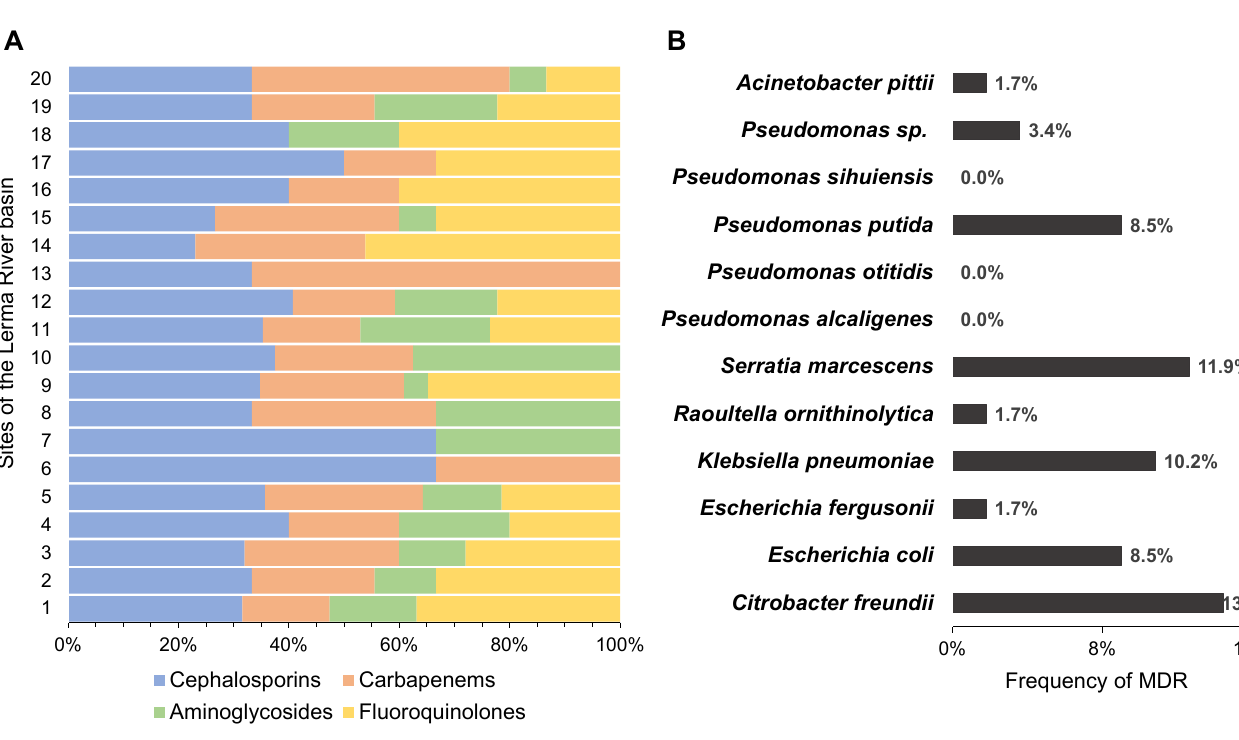
Figure 4. Antimicrobial resistance and MDR in the Lerma River basin. ( A ) Graphical distribution of the studied antimicrobial categories; each number represents locations of the Lerma River (see Figure 5 for details). ( B ) Frequency of environmental MDR strains, by species, found in the Lerma River.